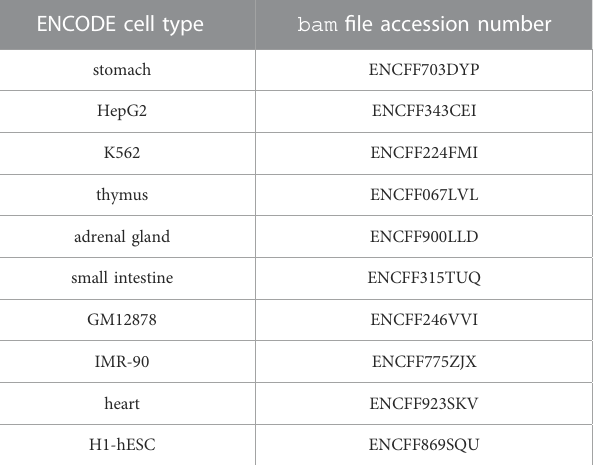
TABLE 3 ENCODE cell types and accession numbers of associated DNA-seq alignment bam fi les. ENCODE cell